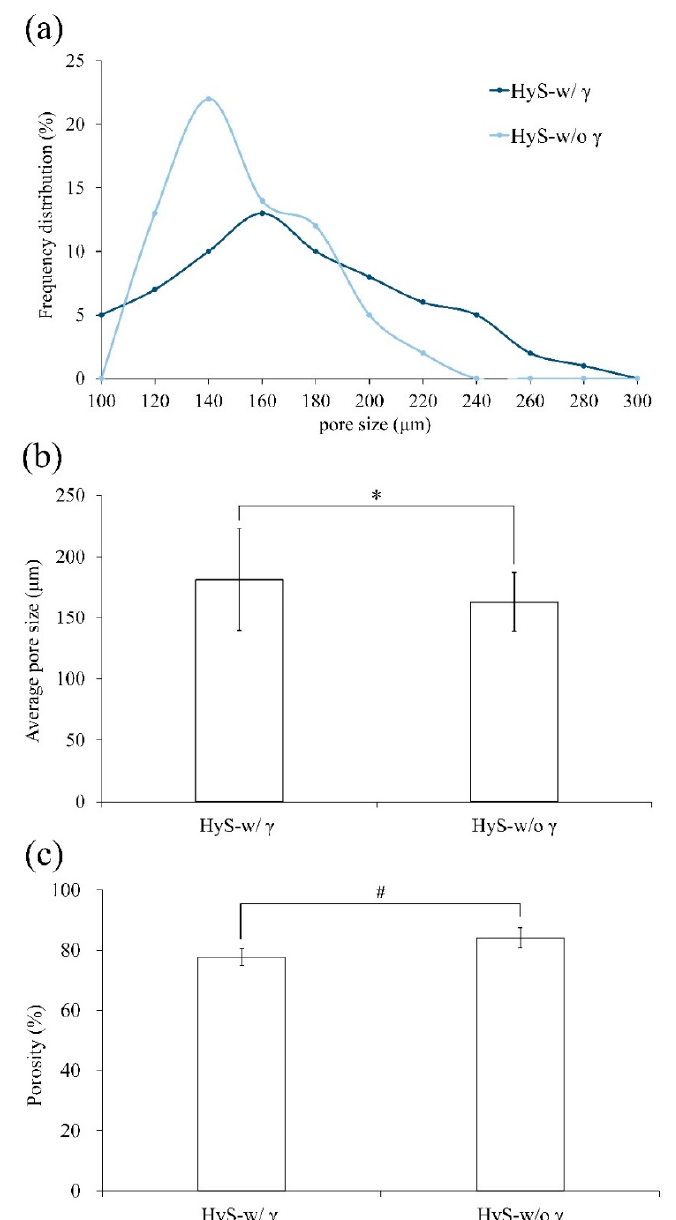
Figure 2. Comparisons of the ( a ) pore size distribution, ( b ) average pore size ( n = 60; *: p < 0.05), and ( c ) porosity of hydrogel macrospheres before (HyS-w/o γ ) and after (HyS-w/ γ ) sterilization ( n = 60; #: p > 0.05).